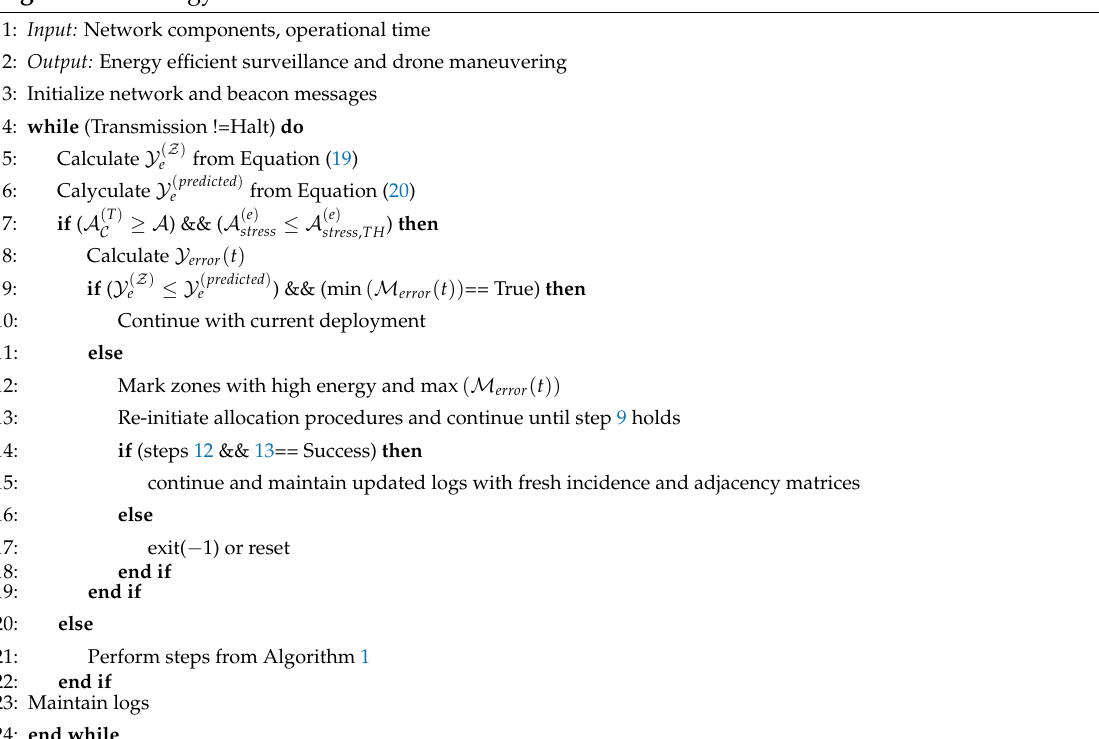
Algorithm 2 Energy efficient